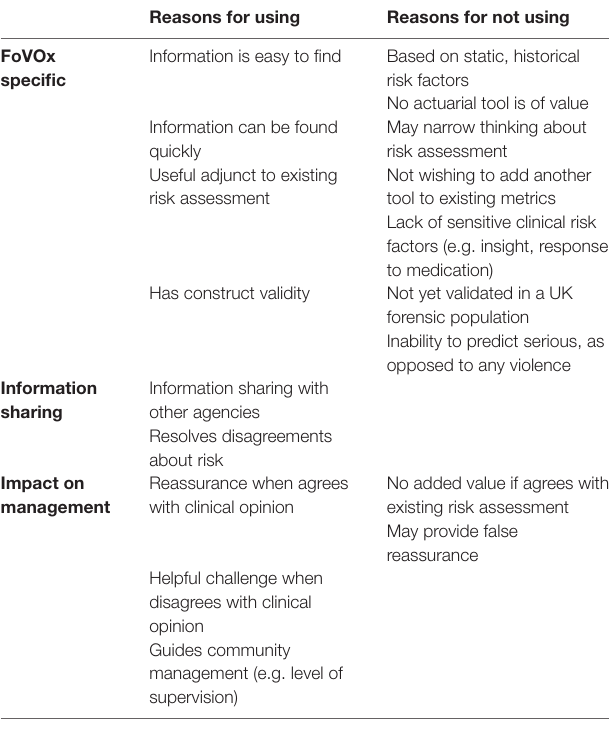
TABle 4 | Qualitative feedback on whether clinicians would use FoVOx in the future.